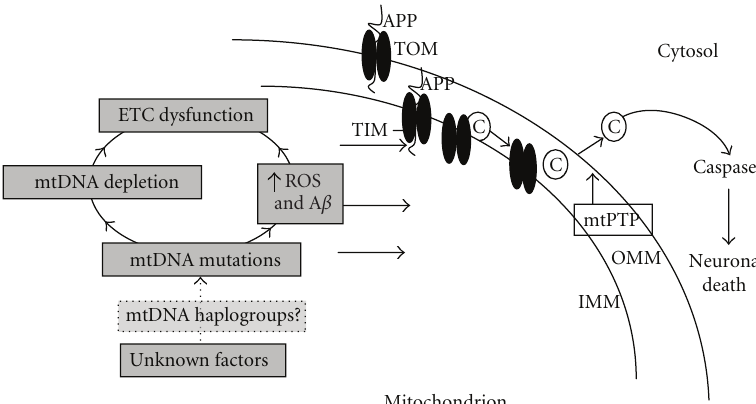
Figure 1: A proposed mechanism of mitochondrial induced cell death in Alzheimer’s disease . Legend: A β ; amyloid- β ; ROS reactive oxygen species; ETC electron transport chain; mtPTP mitochondrial permeability transition pore; C cytochrome c ; IMM inner mitochondrial membrane; OMM outer mitochondrial membrane; APP amyloid precursor protein; TOM and TIM protein importation translocases of the mitochondrial outer and inner membranes. For further details, see text. ( Modified from Mancuso M et al., Antioxid Redox Signal 2007;9:1631– 1646